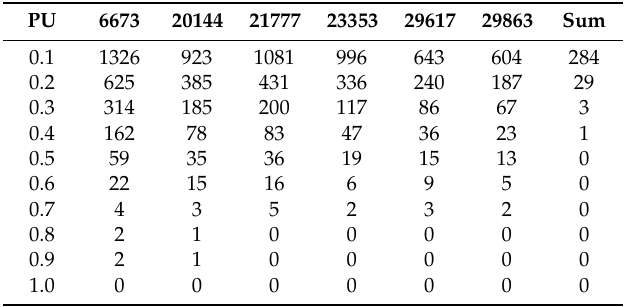
Table 1. Number of upward ramps in 1 h: Rocky Mountains series.